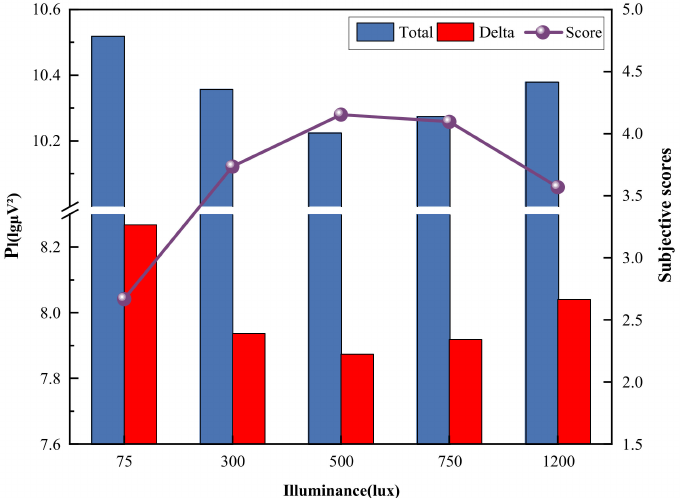
Figure 14. P l of the δ band at the Cz channel with subjective evaluation under different illuminance.